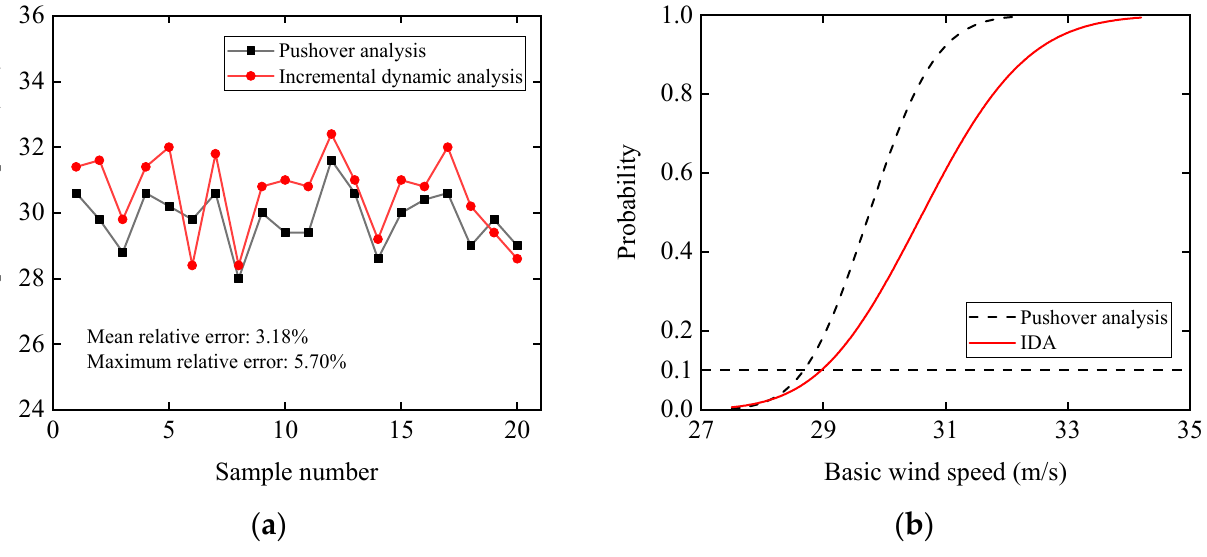
Figure 13. Comparison of pushover analysis and IDA results. ( a ) Comparison results of the basic collapse wind speeds. ( b ) Comparison results of the basic collapse wind speed fragility curves. Based on the collapse wind speed of each sample, the fragility curve corresponding to the incremental dynamic analysis was fitted. The comparison results of the collapse wind speed fragility curves obtained using the two methods are shown in Figure 13b. We observed that the end position of the fragility curve corresponding to the incremental dynamic analysis was farther from the starting position, which was due to the uncertainty of the wind load being considered in the incremental dynamic analysis. The curve of the pushover analysis was on the left side of the curve of the incremental dynamic analysis, and the starting positions of the two curves were close. In the fragility curve corresponding to the incremental dynamic analysis, the basic collapse wind speed corresponding to the 10% probability was 28.96 m/s, which is only 0.97% different from the result of the pushover analysis, which further indicated that the collapse wind speed obtained using the pushover analysis was